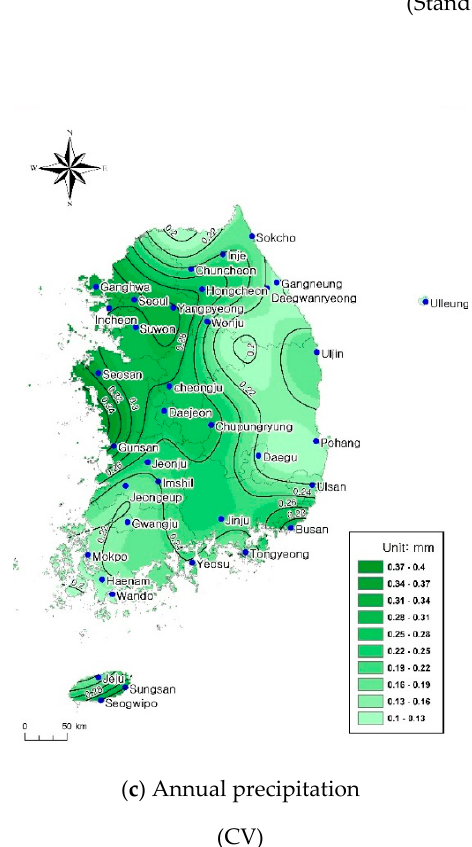
Figure 5. Average, coefficient of variation (CV), and standard deviation of annual precipitation (mm) using the climate change scenarios. ( a ) is the average of the annual precipitation, ( b ) is the standard deviation of the annual precipitation, and ( c ) is the CV value of the annual precipitation.